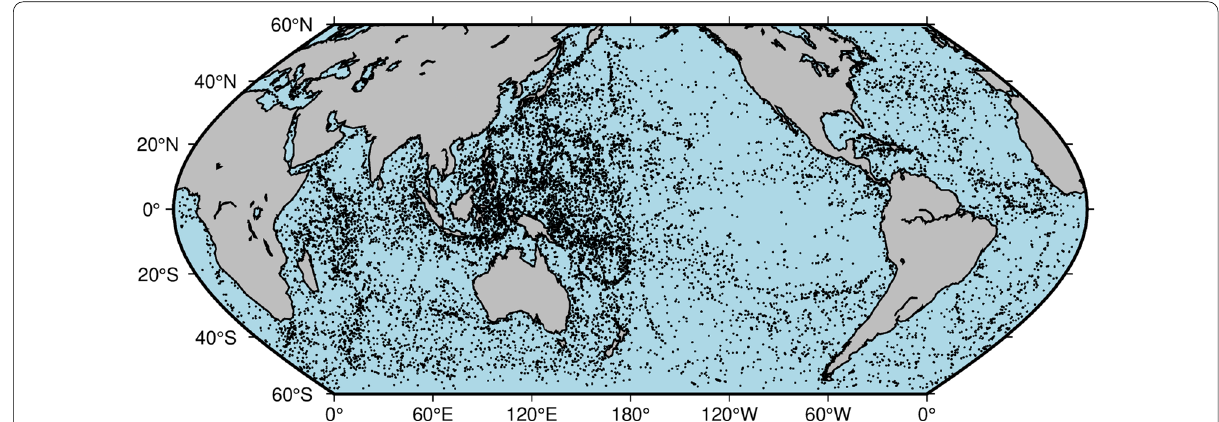
Fig. 7 Distribution of the points, where the accuracy of gravity anomaly is improved by more than 4